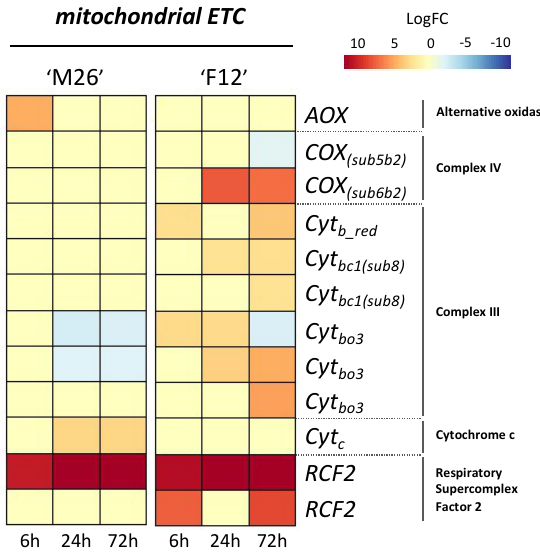
Figure 2. Transcriptomic reconfiguration of pathways involved in mitochondrial electron transport chain in response to O 2 deficiency. The changes in the transcript levels of genes belonging to the mitochondrial electron transport chain typically related to energy metabolism, and that are expressed in a contrasting way between the genotypes, are described. Data obtained from de novo transcriptomic analysis of ‘Mariana 2624’ (‘M26′) and ‘Mazzard F12/1’ (‘F12′). AOX , alternative oxidase; Cyt c , Cytochrome c ; RCF2 , Respiratory Supercomplex Factor 2; Cyt bo3 , Cytochrome bo3 ubiquinol oxidase; Cyt bc1(sub8) , Cytochrome bc1 complex subunit 8; Cyt b red , Cytochrome b reductase; COX (sub5b2) , Cytochrome c oxidase subunit 5b2; COX (sub6b2) , Cytochrome c oxidase subunit 5b2.